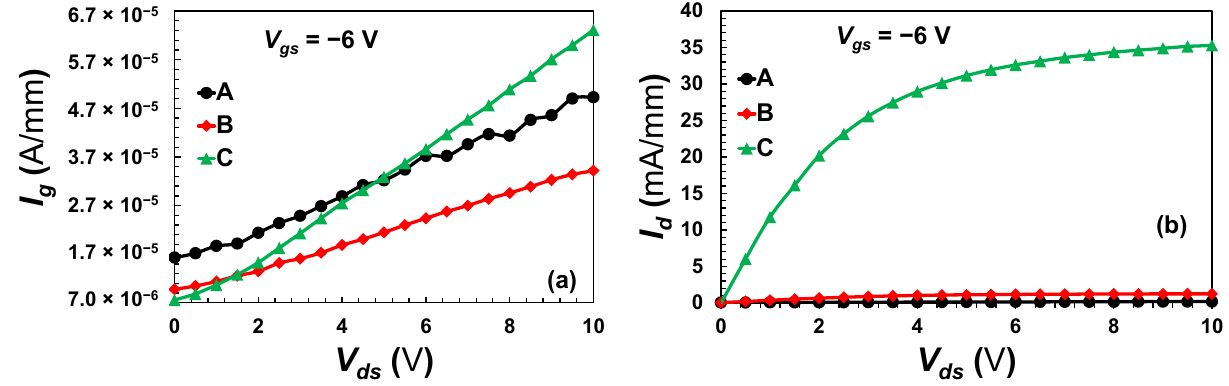
Figure 8. The Off-state gate leakage current ( a ) and the drain leakage current below pinch-off ( b ) as a function of the drain bias.